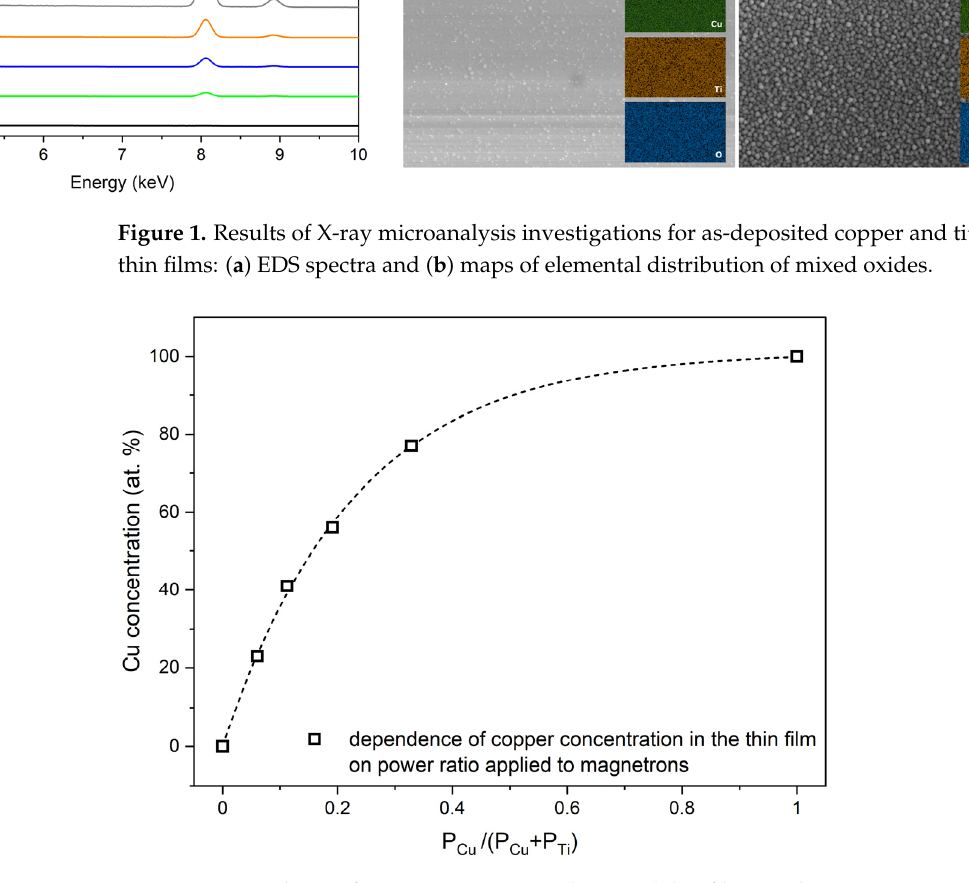
Figure 2. Dependence of copper content in as-deposited thin films on the power ratio P Cu /(P Cu + P Ti ) applied to magnetrons with Cu and Ti targets.